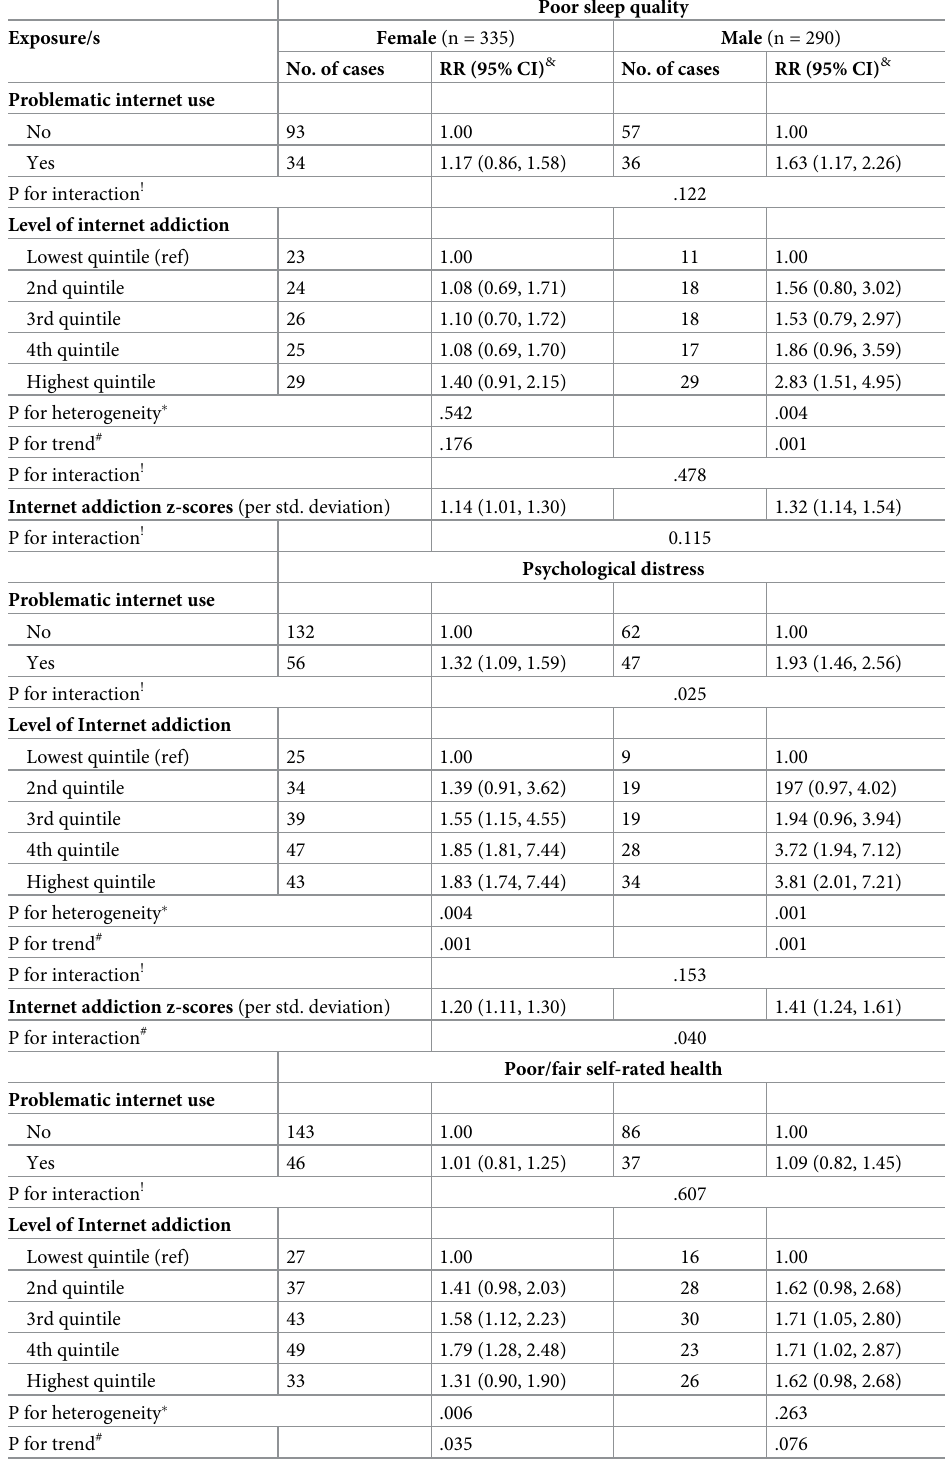
Table 4. Gender-stratified Poisson regression analysis of the associations of internet addiction with poor sleep quality, self-rated health, and psychological